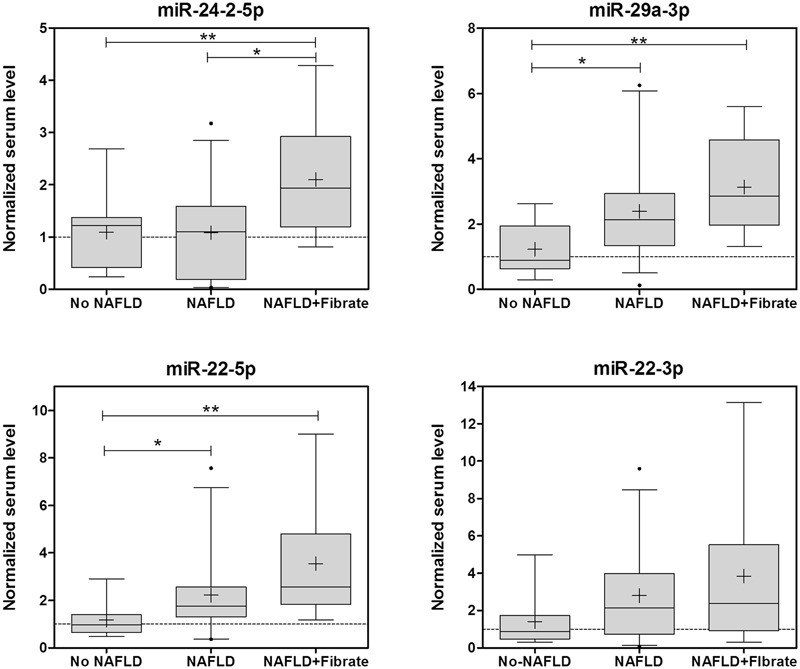
Several biomarker miRNAs for drug-induced steatosis are induced in parallel in the sera of NAFLD patients under fibrate therapy. The levels of miRNA biomarkers were analyzed in the serum of 44 patients with NAFLD and 10 controls. Eleven of the NAFLD patients were taken fibrates regularly. Box plots represent the 25th, the median (black line) and the 75th percentiles, a cross depicts the mean, whiskers indicate the 95th and 5th percentile and dots represent outliers. ∗p < 0.05, ∗∗p < 0.01, ANOVA, Tukey post hoc.